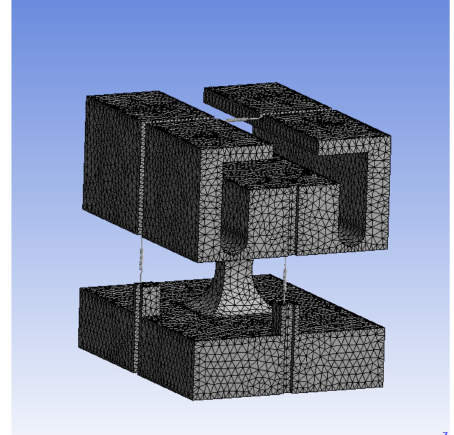
Figure 13. Schematic of accelerometer